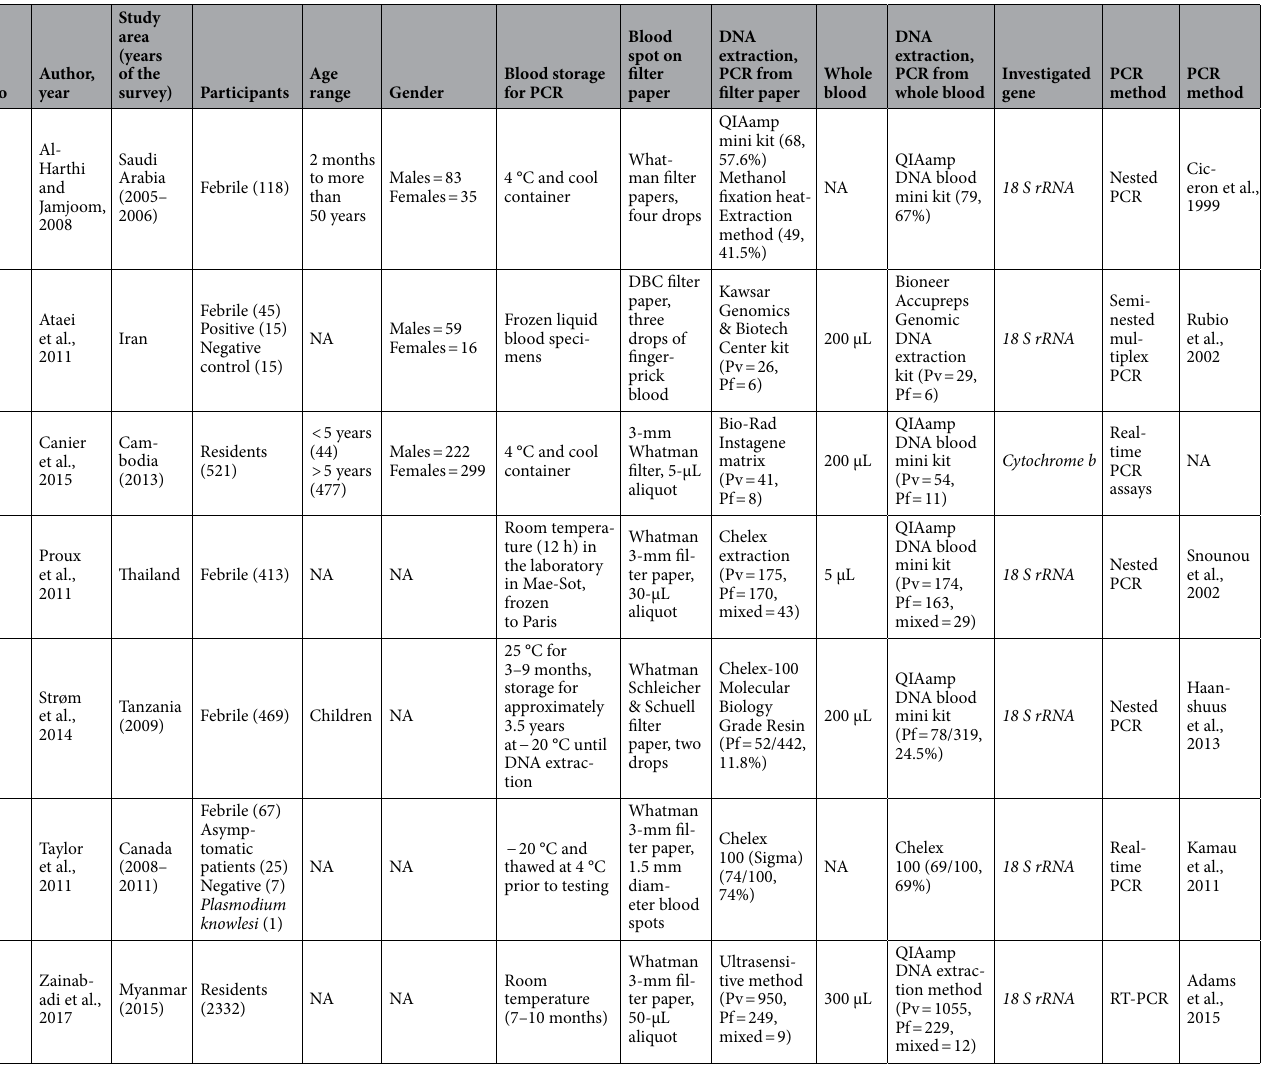
Table 1. Characteristics of the included studies. Pv Plasmodium vivax , Pf Plasmodium falciparum , mixed mixed infection, NA Not